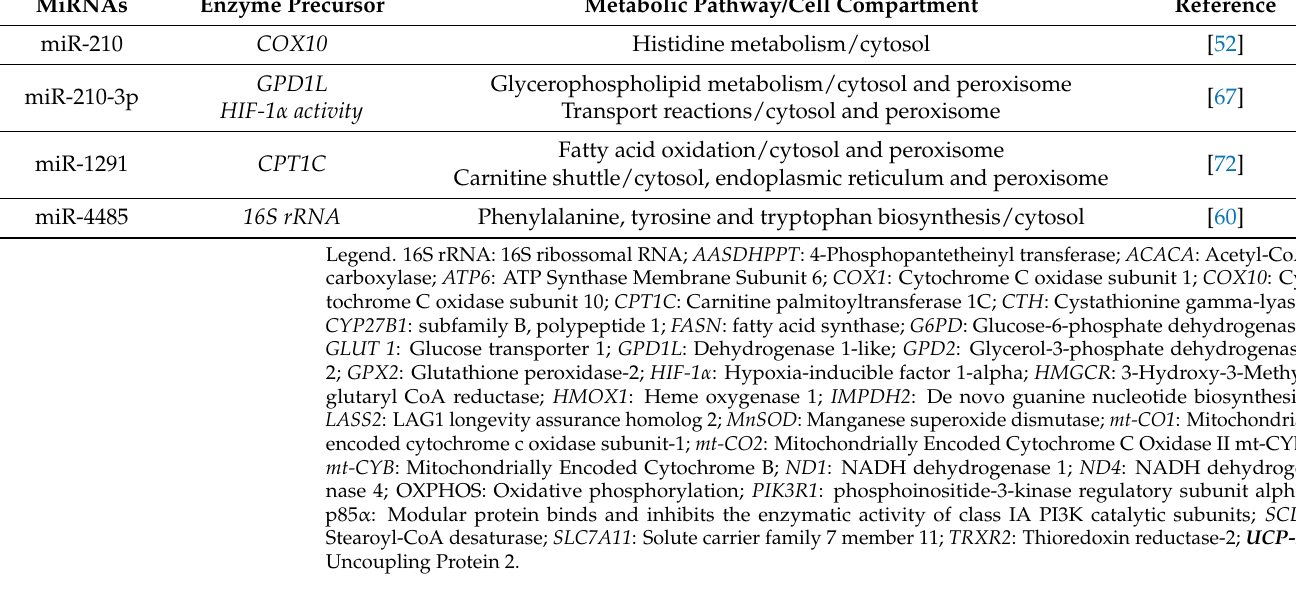
Table 4. MiRNAs with oncogenic and suppressive function mediating cytotoxic response to